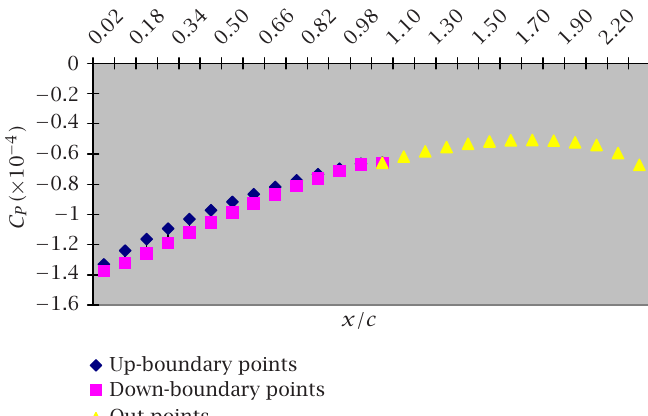
Figure 6.5 . Pressure distribution around the aircraft of Figure 5.1, for linear vortex distribution and speed 3Mach.